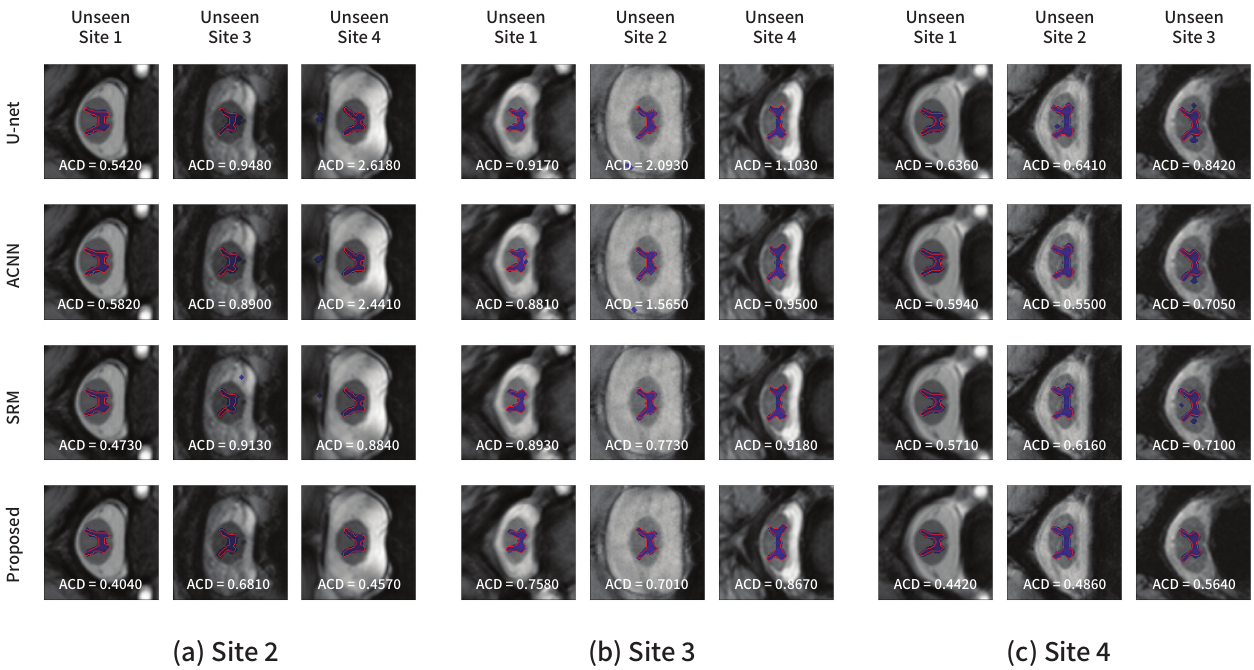
Figure 7. Segmentation results on the spinal cord segmentation task obtained from the models trained using the ( a ) site2 , ( b ) site3 , and ( c ) site4 datasets, respectively. The blue color represents the segmentation results, and the ground-truth is in